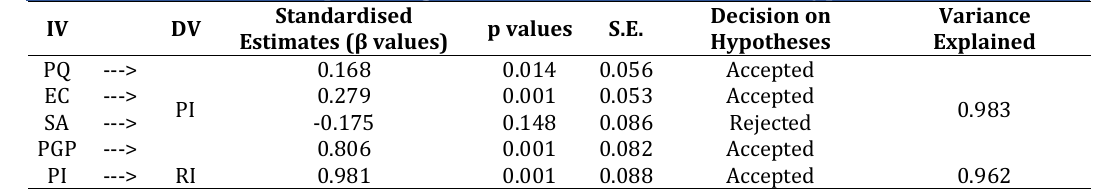
Table 5: Paths relationships among constructs and confirmation of